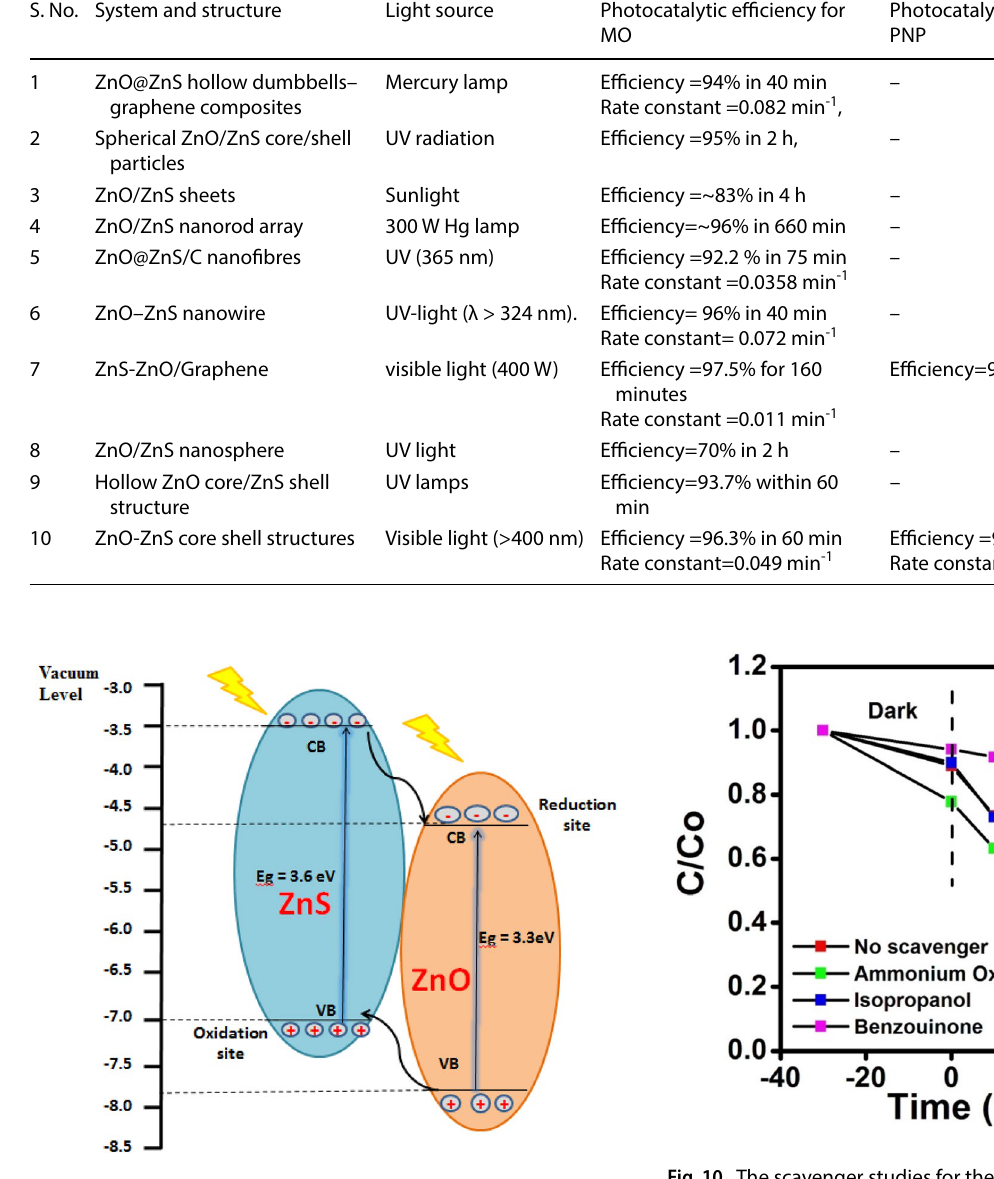
Fig. 10 The scavenger studies for the detection of active species for the photodegradation of methyl orange in the presence of